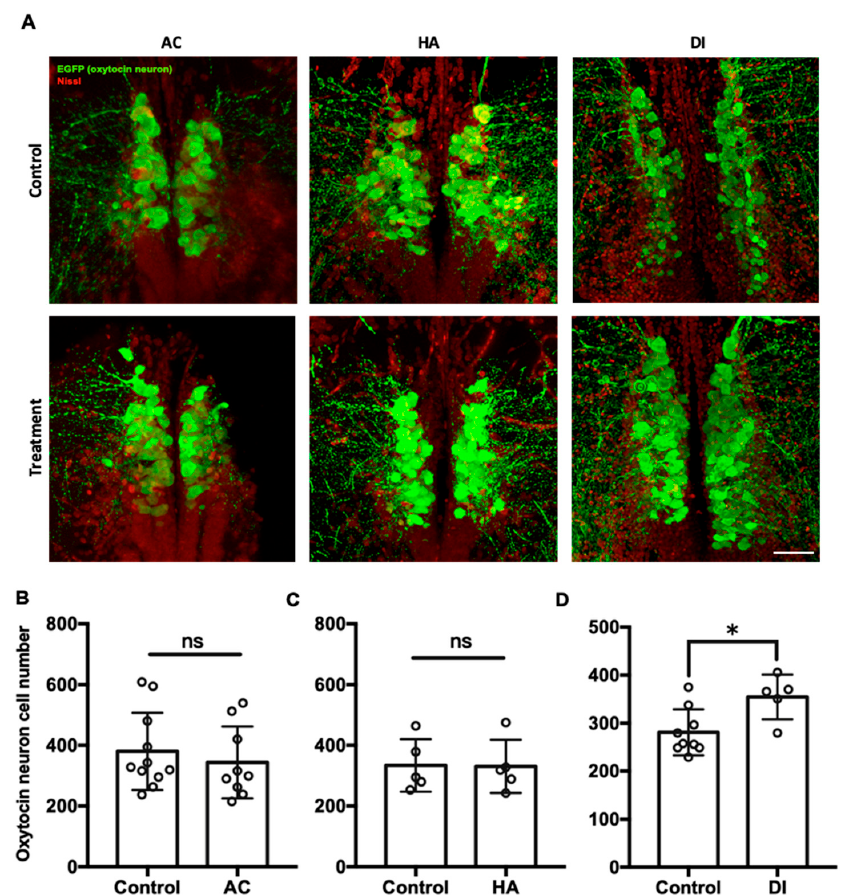
Figure 4. Confocal laser scanning micrographs of the sections of the brain of transgenic zebrafish (oxtl:EGFP) acclimated to AC, HA, or DI water stained with anti-GFP (green; oxytocin) and Nissl (red) ( A ). Scale bar = 50 µm. The total numbers of oxytocin neurons in the brain of transgenic zebrafish treated with AC ( B ), HA ( C ), and DI ( D ) water were counted through the section sets from whole brain. Each circle represents the data from one single fish. In AC treatment, n = 11 for control group; n = 9 for the treatment group. In HA treatment, n = 5 for both control and treatment group. In DI treatment, n = 9 for control group; n = 5 for the treatment group. The asterisks (*) indicate significant differences between the control and treatment groups; ns indicates that no significant difference was found between the control and treatment groups. Values are mean ± SD ( p < 0.05 (Student’s t